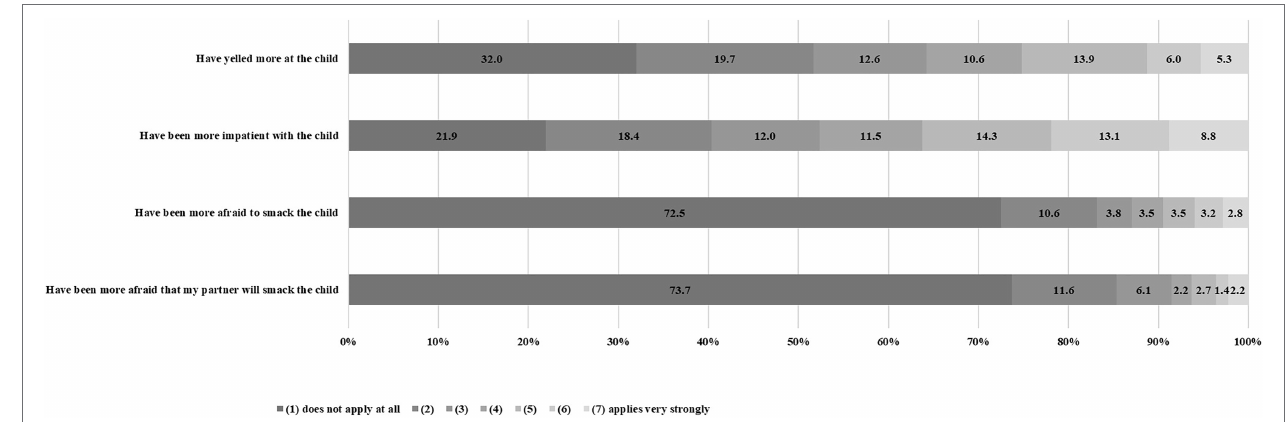
FIGURE 1 | Increase of potential harmful parenting actions since the beginning of the pandemic. Change of potential harmful parenting behavior since the beginning of the